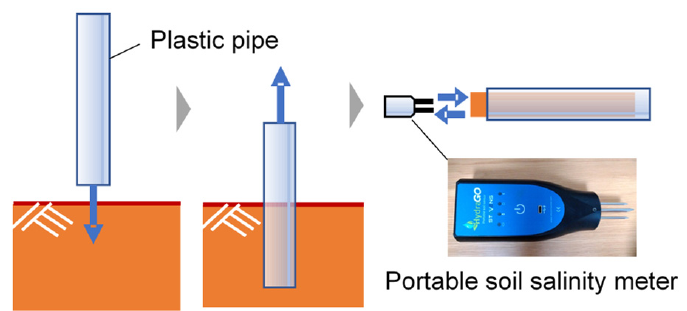
Figure 7. Observation method of soil salinity.